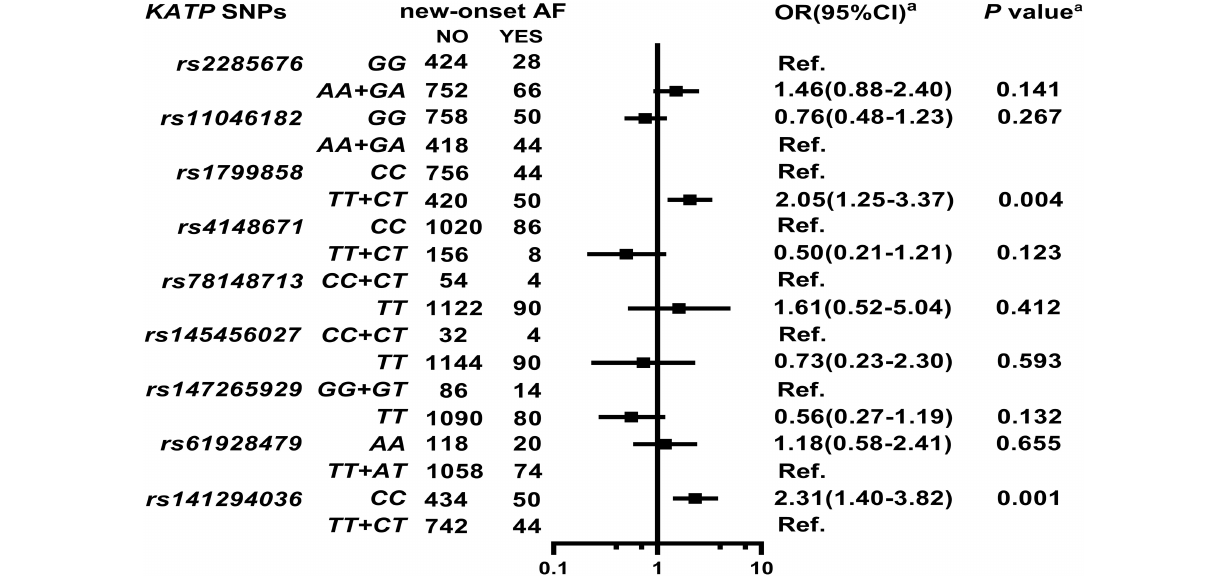
efficacy of sulfonylurea hypoglycemic agents (e.g., gliclazide)